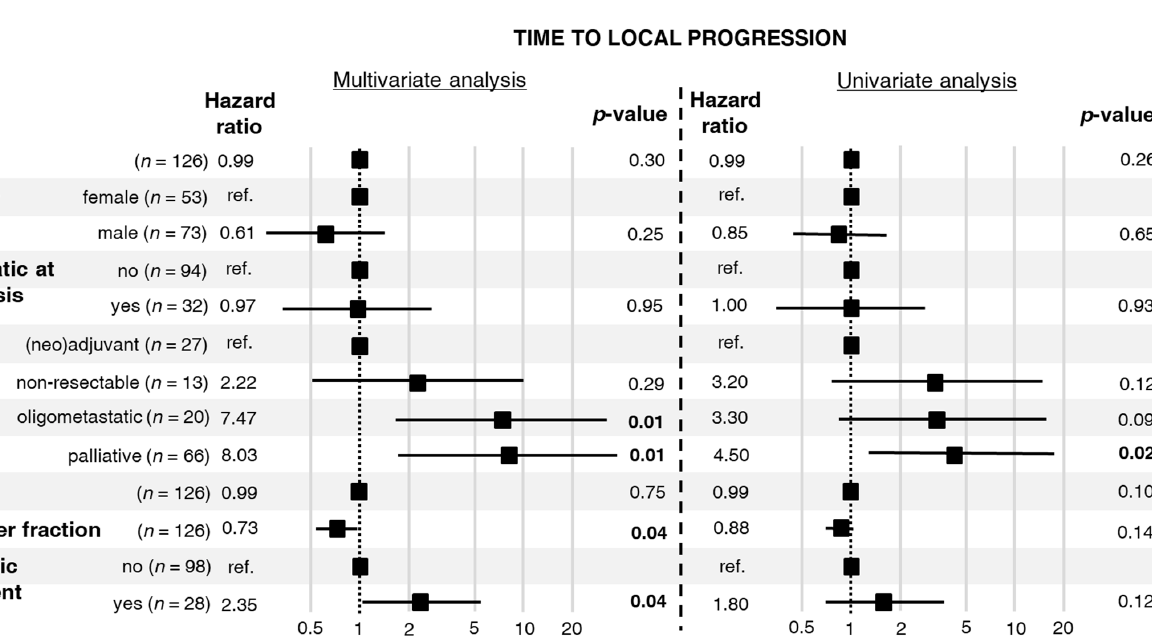
Figure 1. Hazard ratios for local progression with 95% confidence intervals and p -values calculated from a multivariate and a univariate Cox proportional hazards model.